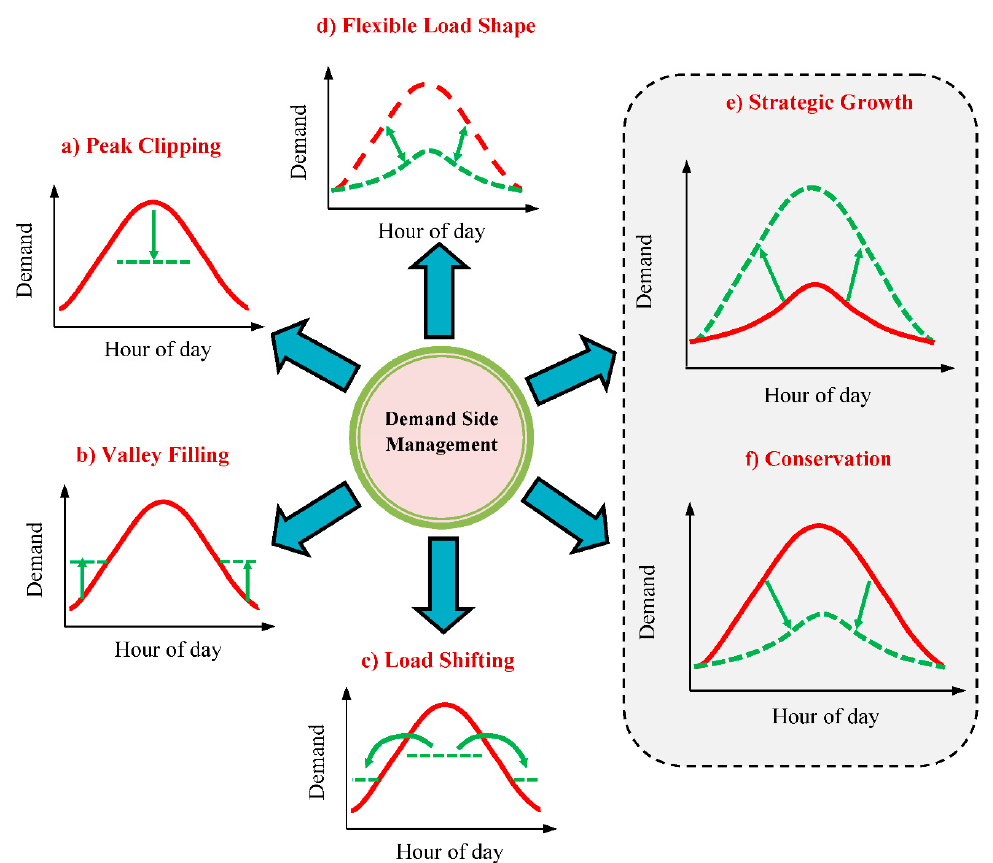
Figure 2. Overall view of DSM methods.